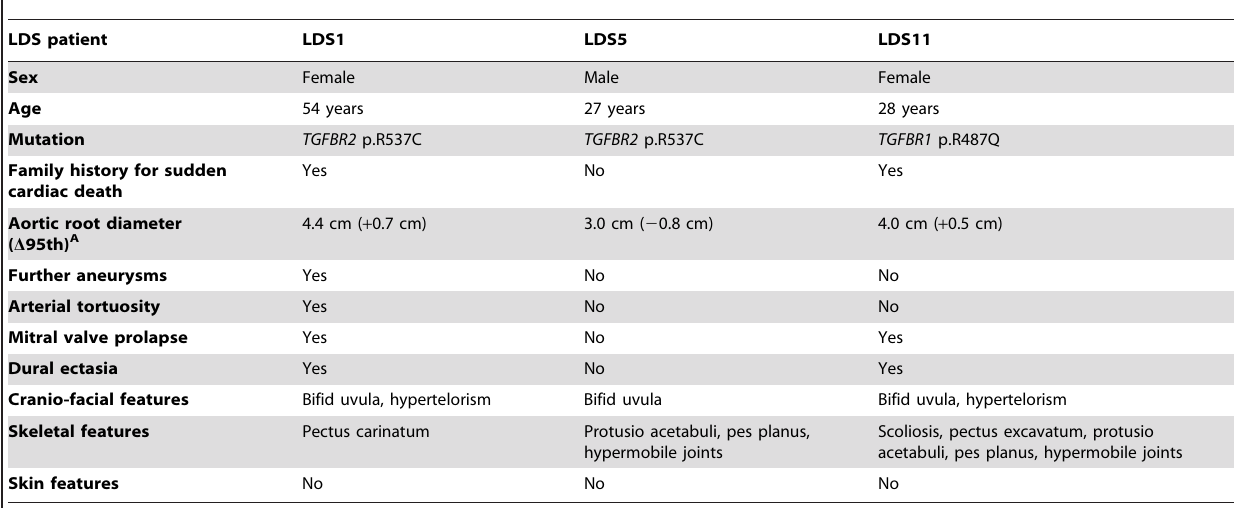
Table 3. Patient characteristics of LDS1, LDS5 and LDS11.